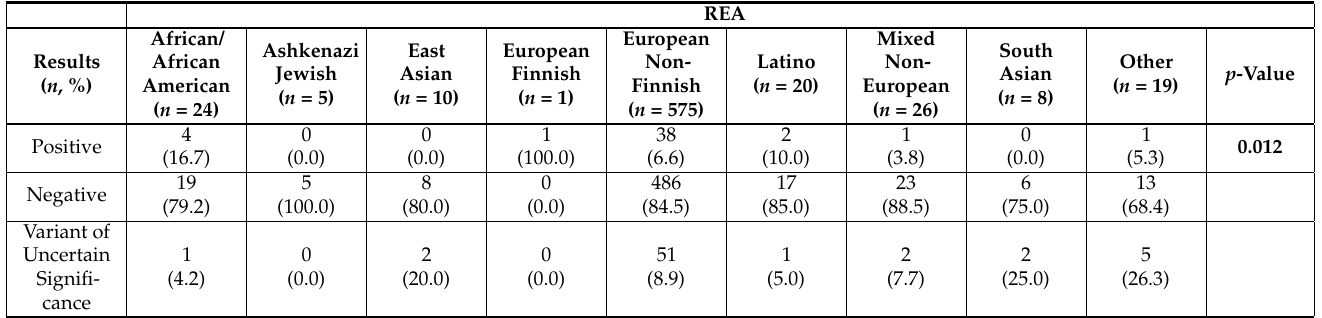
Table 4. Identification of positive, negative, and uncertain results on multigene sequencing panels across all REA groups.